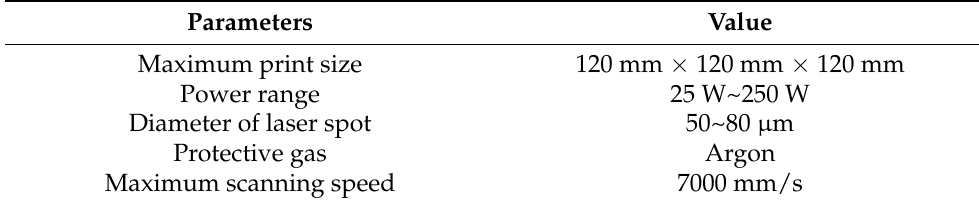
Table 2. Basic parameters of the SLM